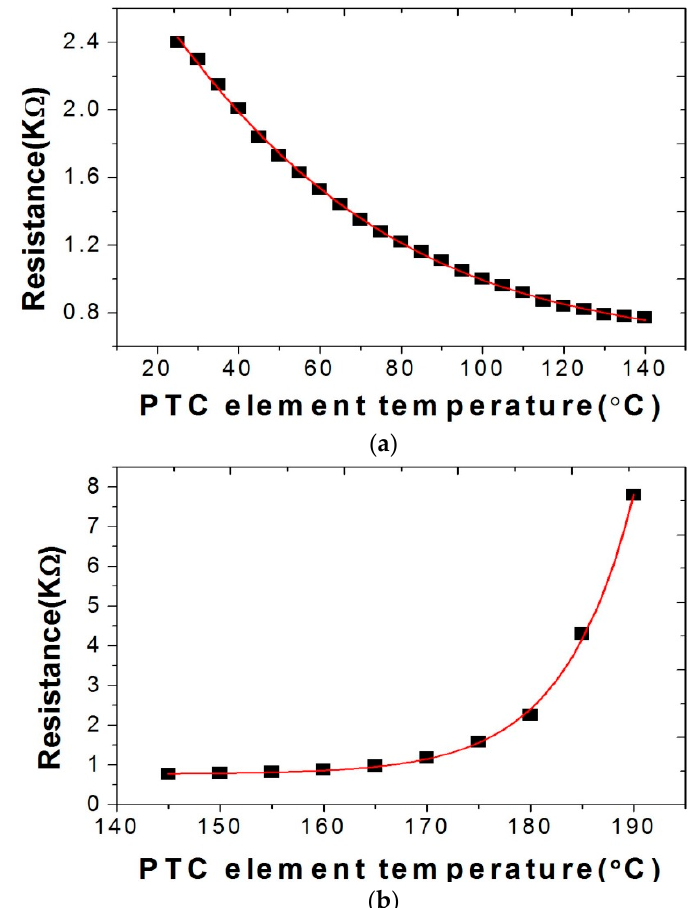
Figure 4. Resistance–Temperature curve of PTC, ( a ) exponential fitting form 25 °C to 140 °C, ( b ) cubic fitting after 145 °C.